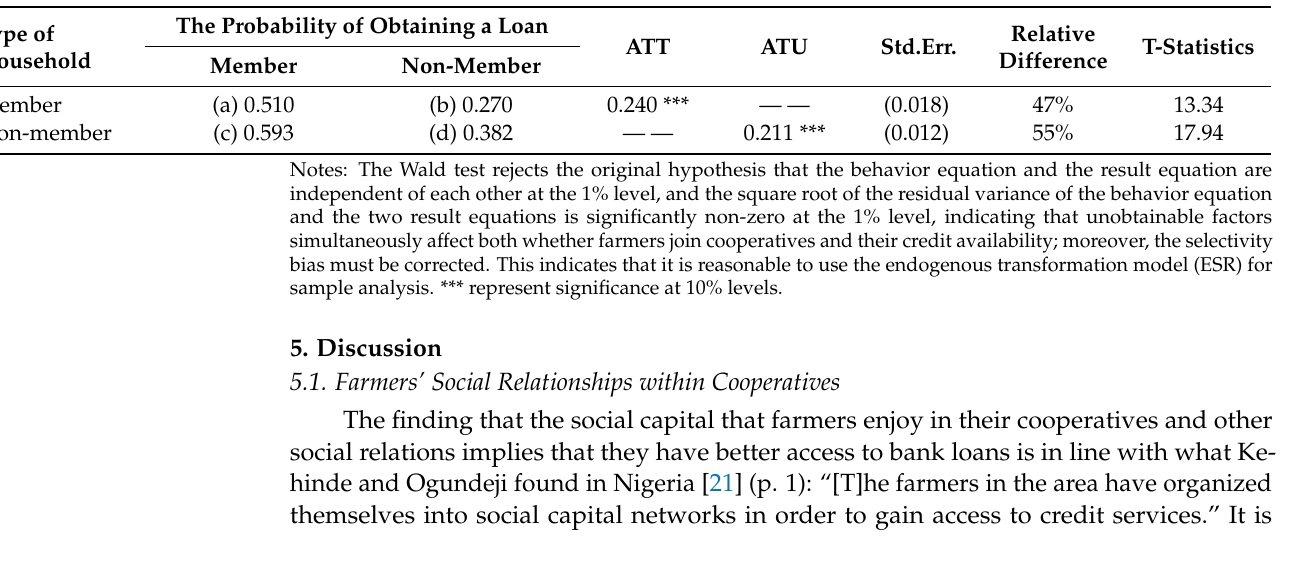
Table 8. Balance test result from ESR